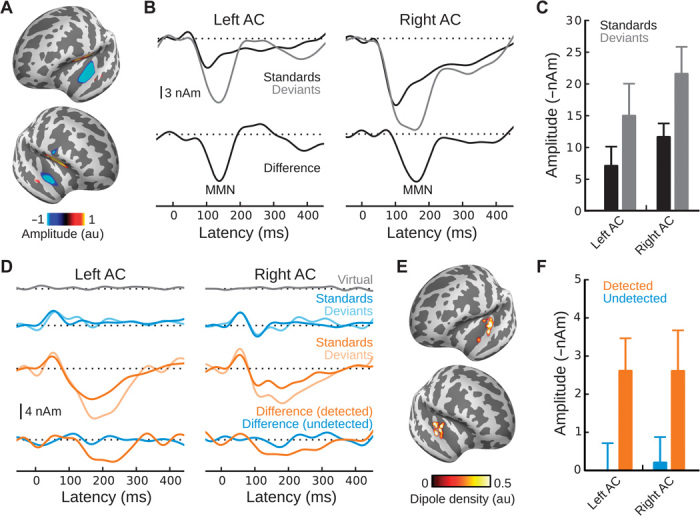
Neural activity in the control (A to C) and masked (D to F) conditions.(A) Grand-average normalized dSPM between 100 and 150 ms for deviants minus standards under control (unmasked) conditions. (B) Grand-average MxNE solutions for (top) standards (black traces) and deviants (gray traces) and (bottom) their respective difference waveforms. (C) Quantified amplitudes for standards (black) and deviants (gray). (D) Grand-average MxNE solutions for virtual targets (gray), deviants and standards for undetected standard streams (blue), deviants and standards for detected standard streams (orange), and their respective difference waveforms (deviants minus standards). (E) Corresponding dipole locations. (F) Quantified amplitudes for MMN responses generated in the context of detected (orange) and undetected (blue) standard streams. au, arbitrary units.